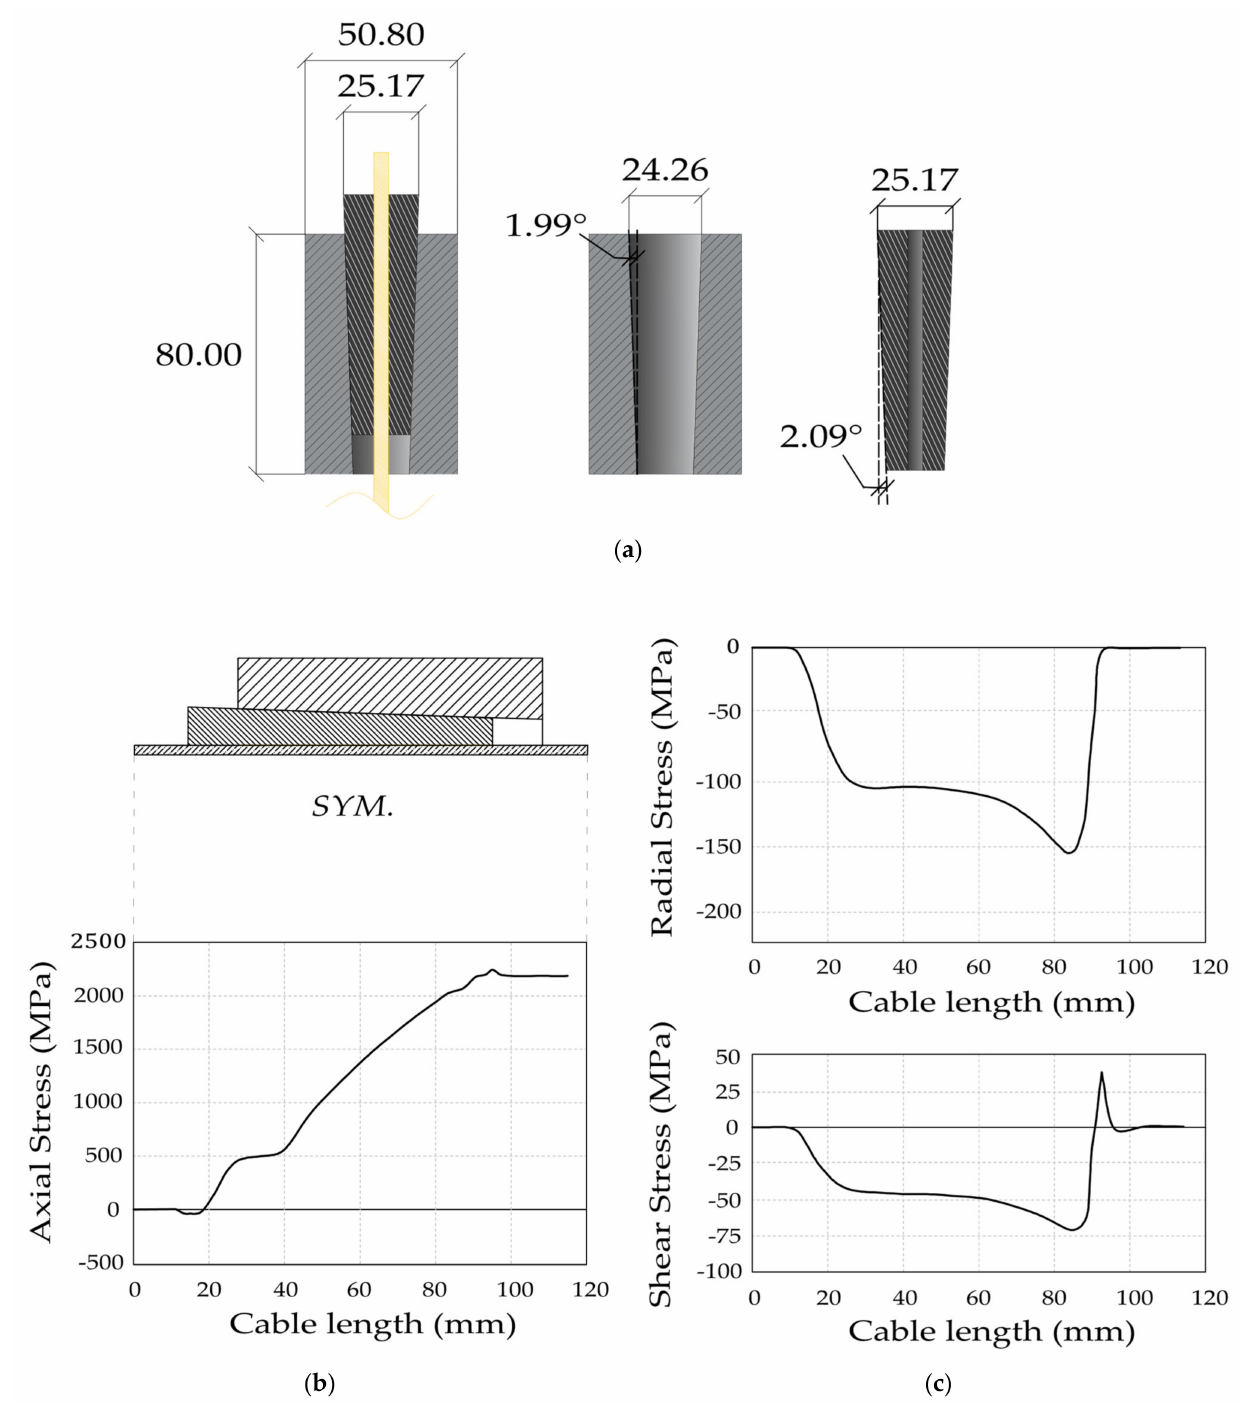
Figure 9. Split wedge anchorage developed by Sayed-Ahmed et al. [22]: ( a ) geometry of the model with differential angle between the barrel and wedges (dimensions in millimeters); ( b ) FEM analyses: longitudinal stress distribution along the cable length; ( c ) FEM analyses–Top: radial stress distribution; Bottom: shear stress distribution. Reproduction of results reported in Sayed-Ahmed et al.